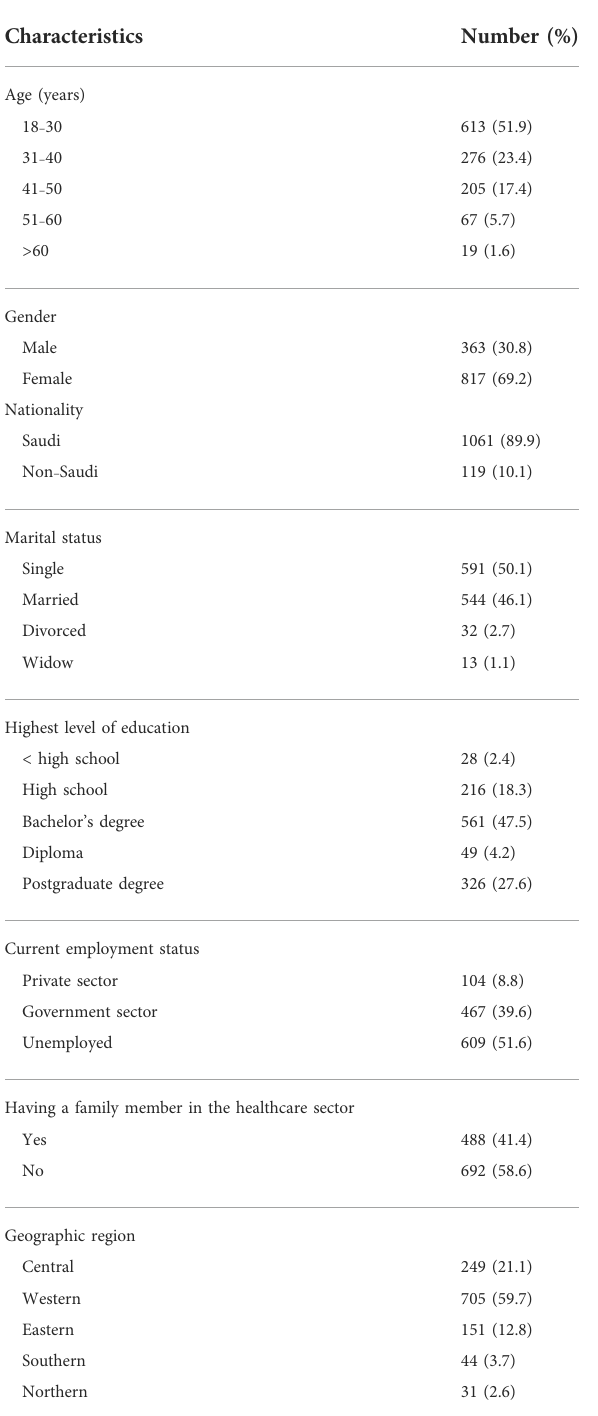
TABLE 1 Participants ’ demographic characteristics. TABLE 2 Participants ’ clinical